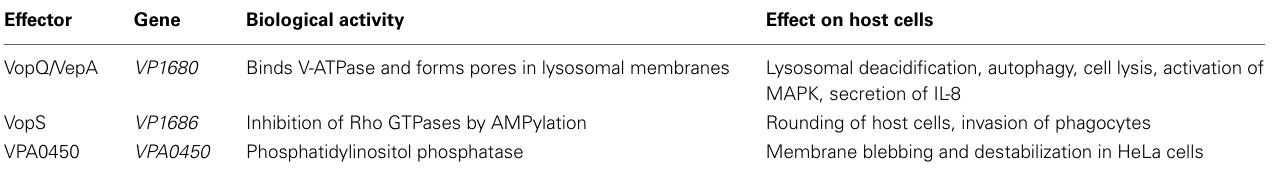
Table 2 | Characterized V. parahaemolyticus TTSS1 effectors and their role in